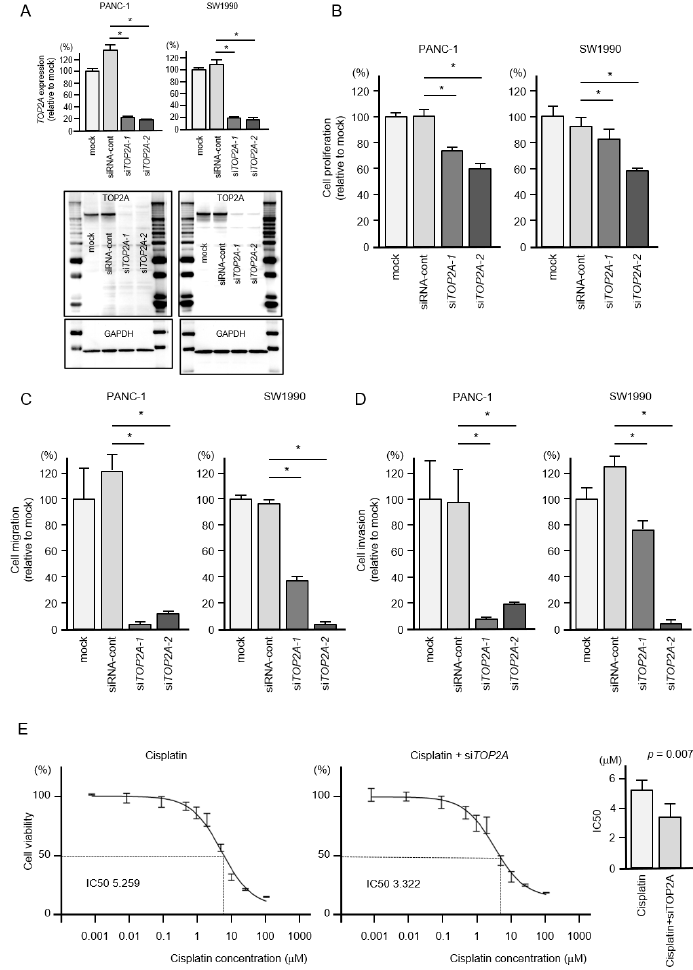
Figure 7. Effects of TOP2A knockdown in PDAC cells. ( A ) Validation of TOP2A knockdown efficiency in siRNA-transfected PDAC cells. The mRNA expression levels of TOP2A were significantly reduced by miR-30c-2-3p transfection into PANC-1 and SW1990 cells. The protein expression levels of TOP2A were significantly reduced by transfection of two siRNAs (si TOP2A -1 and si TOP2A -2) into PANC-1 and SW1990 cells (measured 72 h after transfection). Images of whole Western blot gels are shown. GAPDH was used as an internal control. ( B ) Cell proliferation was measured by the XTT assay. Data were collected 72 h after siRNA transfection (* p < 0.0001). ( C ) Cell migration was measured using a membrane culture system. Data were collected 48 h after seeding the cells into chambers (* p < 0.0001). ( D ) Cell invasion was determined 48 h after seeding miRNA-transfected cells into chambers using Matrigel invasion assays (* p < 0.0001). ( E ) In PDAC cells, si TOP2A increased the sensitivity to the anticancer drug cisplatin. Half maximal inhibitory concentration (IC 50 ) values were worked out by using GraphPad Prism8